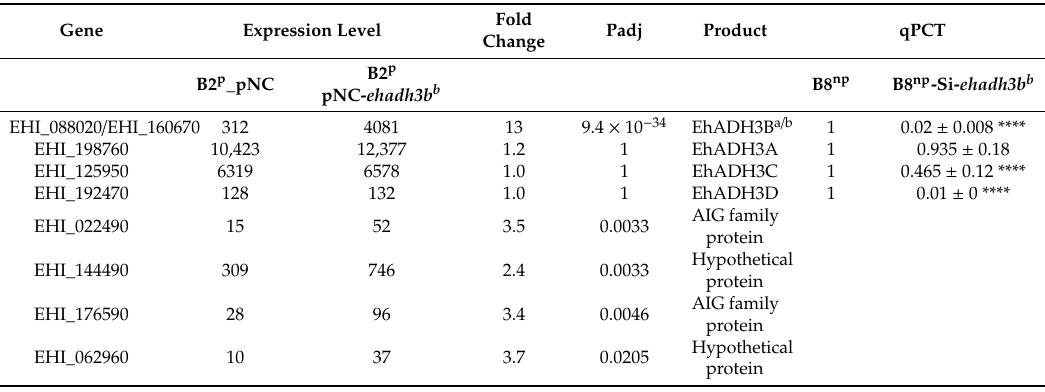
Table 3. Expression levels of genes di ff erentially expressed between B2 p _pNC transfectants